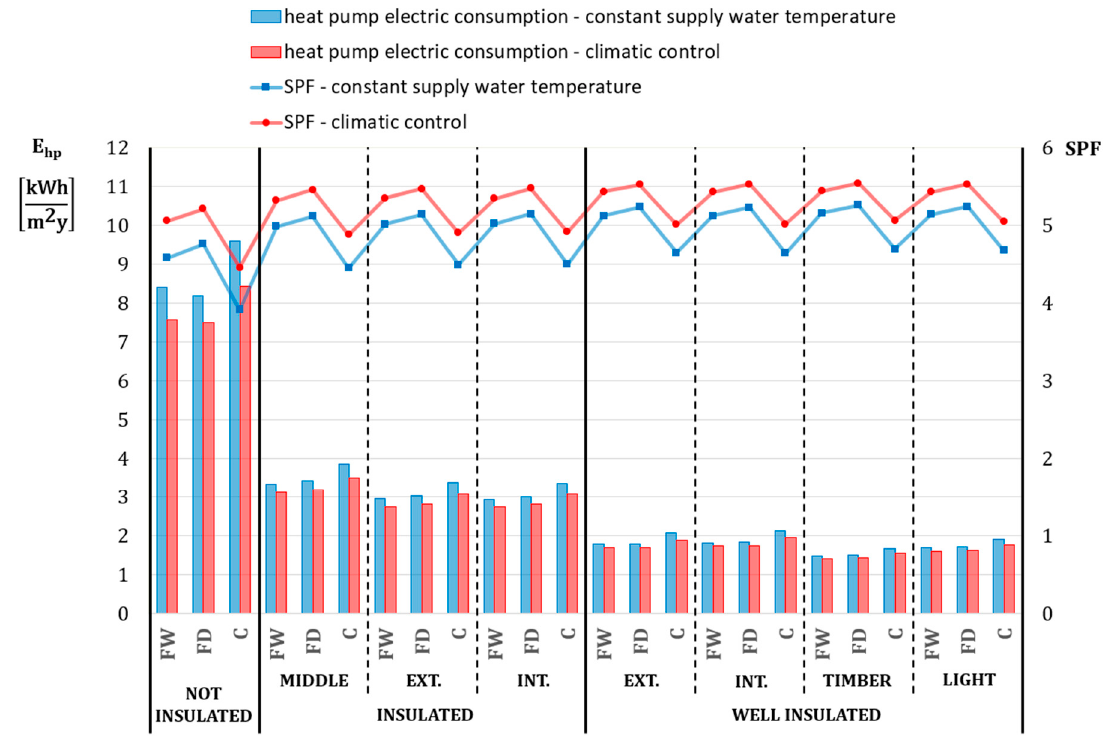
Figure 10. Heat pump electric energy consumption and seasonal performance factor with constant supply water temperature and climatic control. Table 10. Electric energy consumptions and percentage difference between climatic control and constant supply water